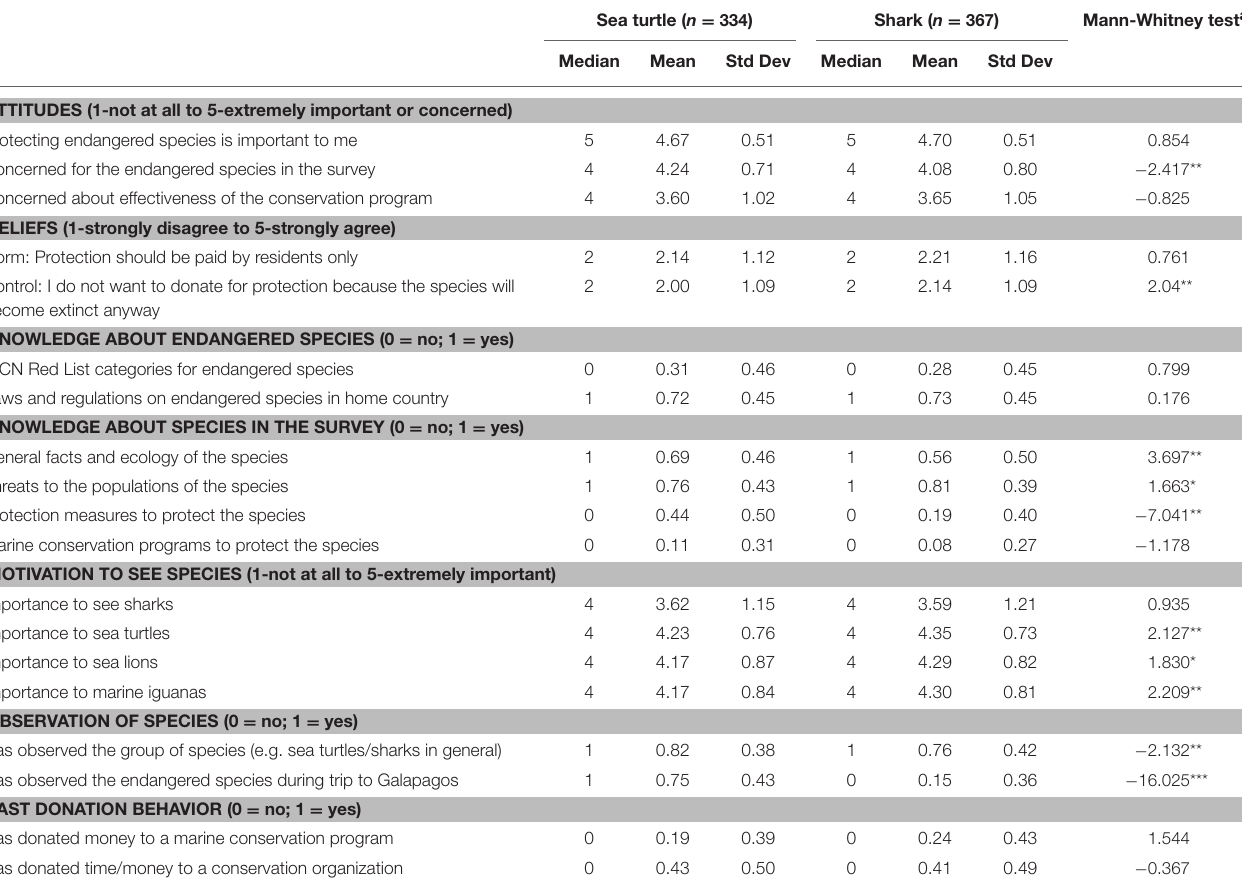
TABLE 2 | Factors influencing WTD—descriptive